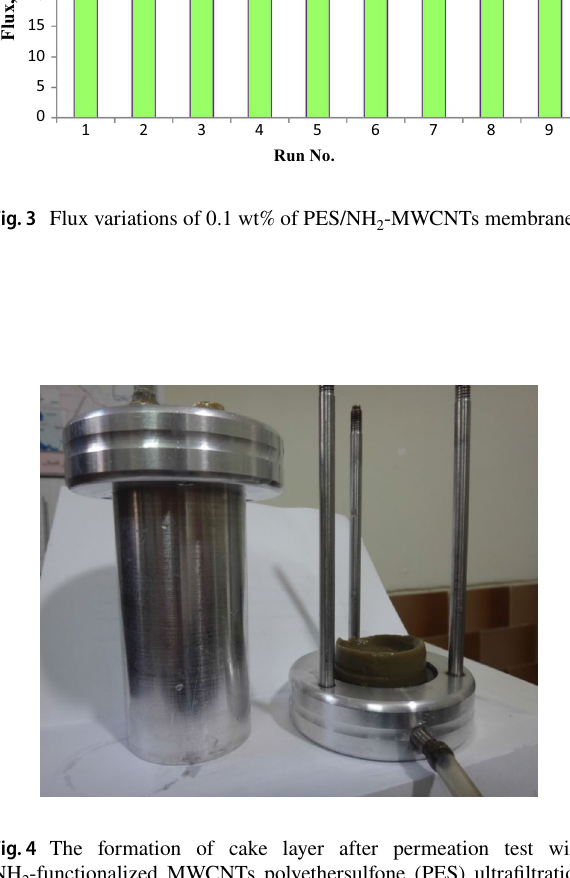
Fig. 4 The formation of cake layer after permeation test